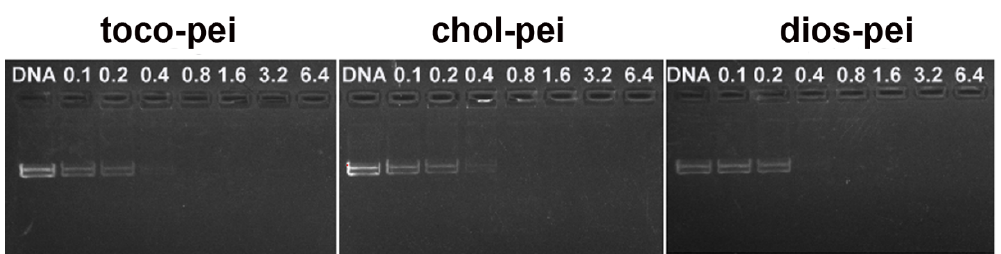
Figure 4. Agarose gel electrophoresis, from left to right: plasmid DNA (pDNA), and lipopolymer/DNA complexes with w / w concentrations of 0.1, 0.2, 0.4, 0.8, 1.6, 3.2, and 6.4.